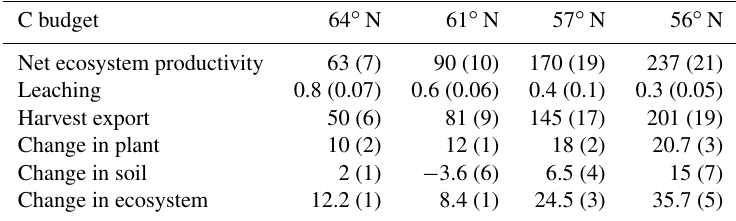
Table B3. Simulated annual C budget, including the associated uncertainty range (mean ± SD in gCm − 2 yr − 1